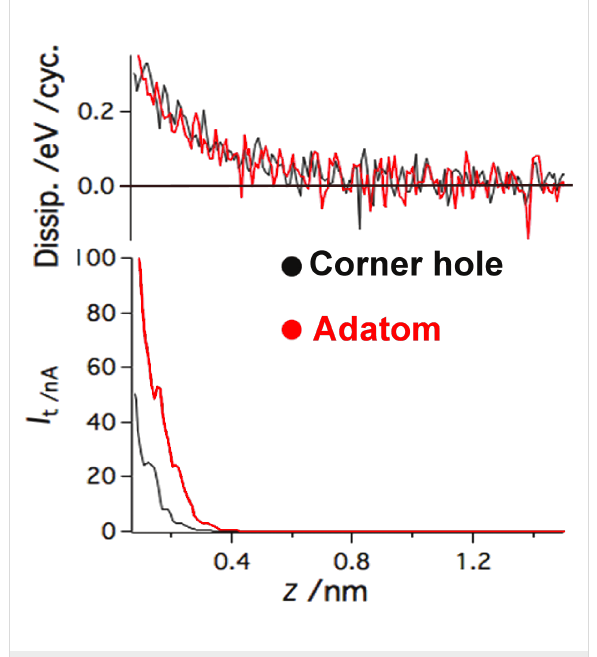
Figure 9: Analyses of the impact of the tunneling current on dissipa- tion. It can be clearly seen that the tunneling current does not affect the dissipation, either directly (by cross-talk) or indirectly by induced nonconservative forces